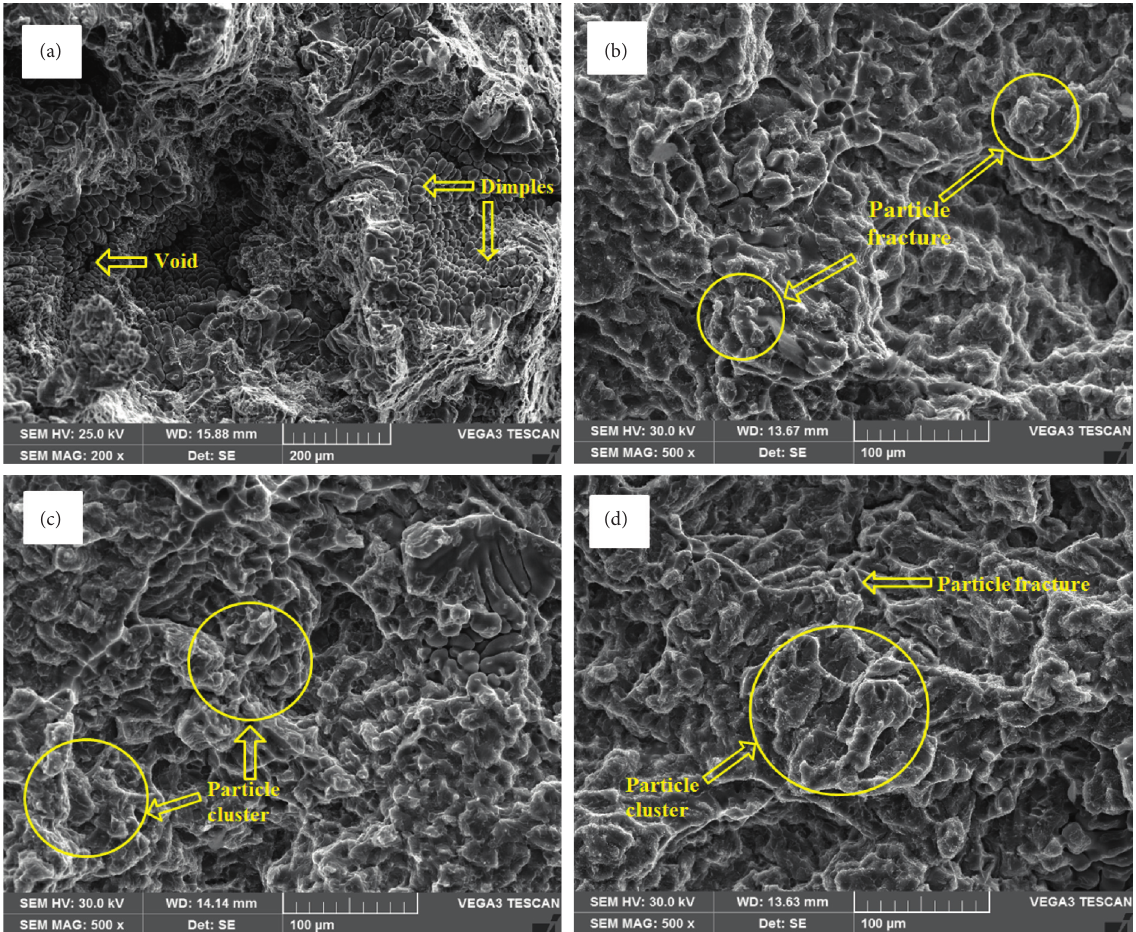
Figure 7: SEM microphotographs of tensile fracture surfaces of AA6082/TiB (d)